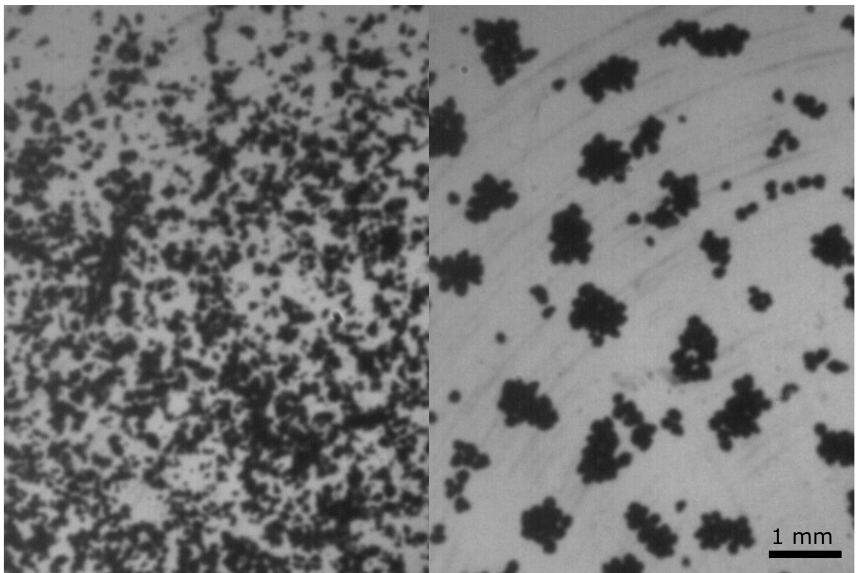
Figure 2. Initial and final ensemble in a laboratory experiment where dust aggregates are levitated at low ambient pressure on a hot surface by a self-generated Knudsen compressor. Starting with 100 micrometer dust aggregates, mm-aggregatges grow at speeds of mm/s to cm/s. (from Demirci et al.